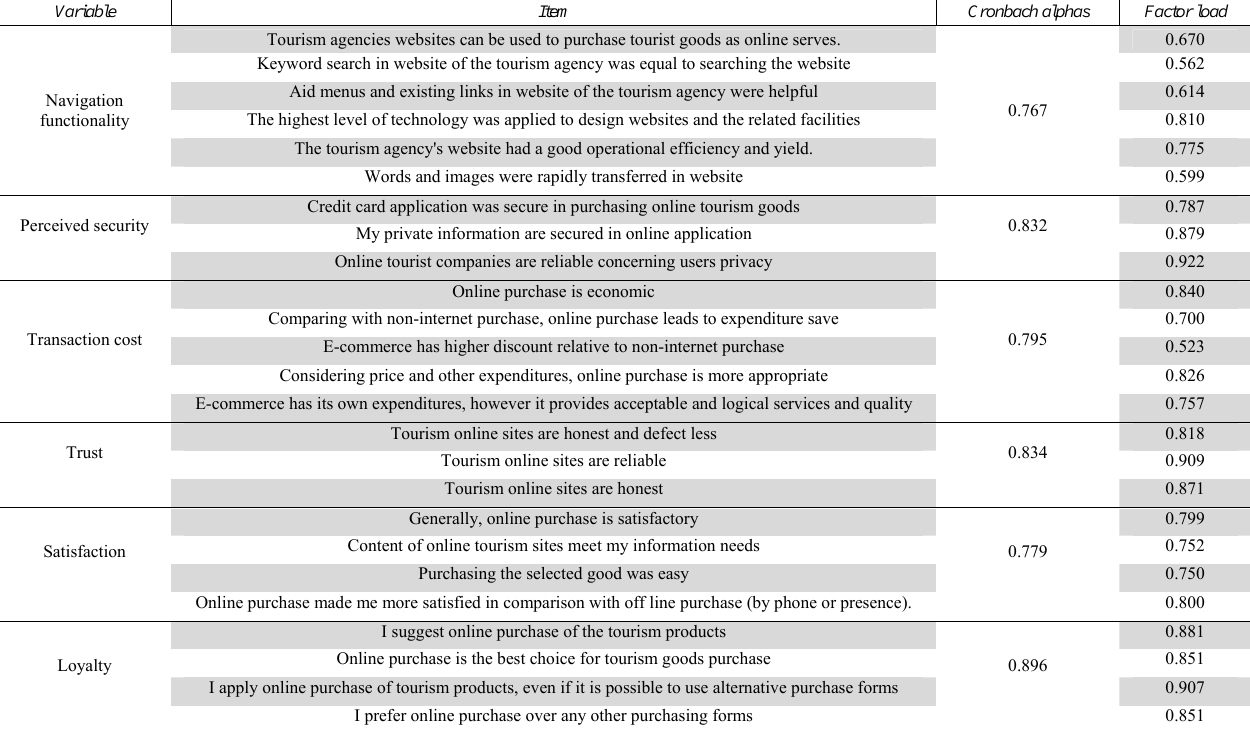
Results of confirmatory factor analysis and Cronbach